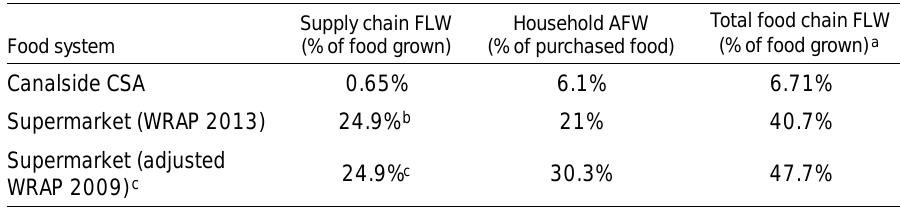
Table 4. Complete Food Chain Comparison of Food Loss and Waste (FLW)